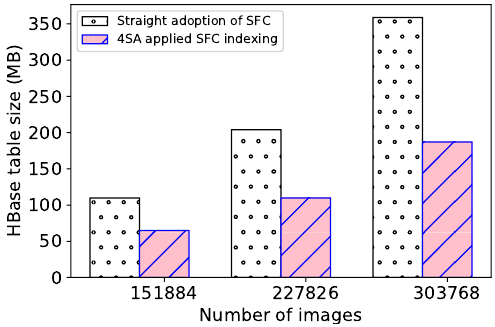
Figure 6. Storage requirements for SFC based indexing with and without 4SA Table 2. Impact of 4SA on processing of IOIs on window